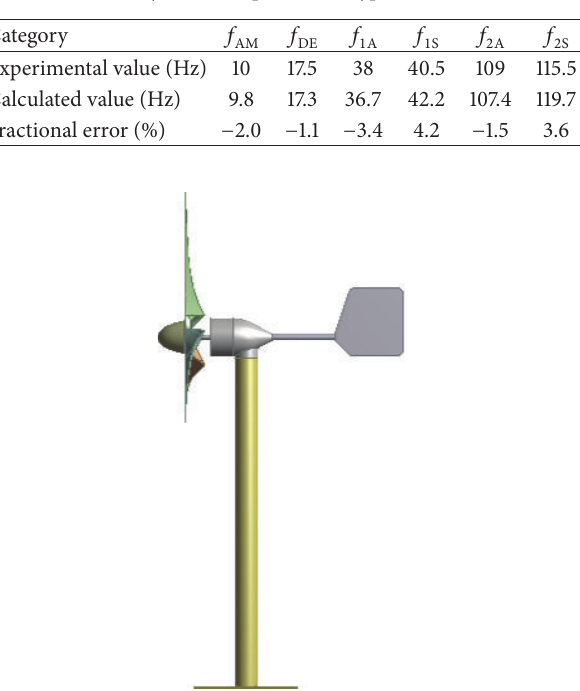
Table 2: Dynamic frequencies of typical vibrations.